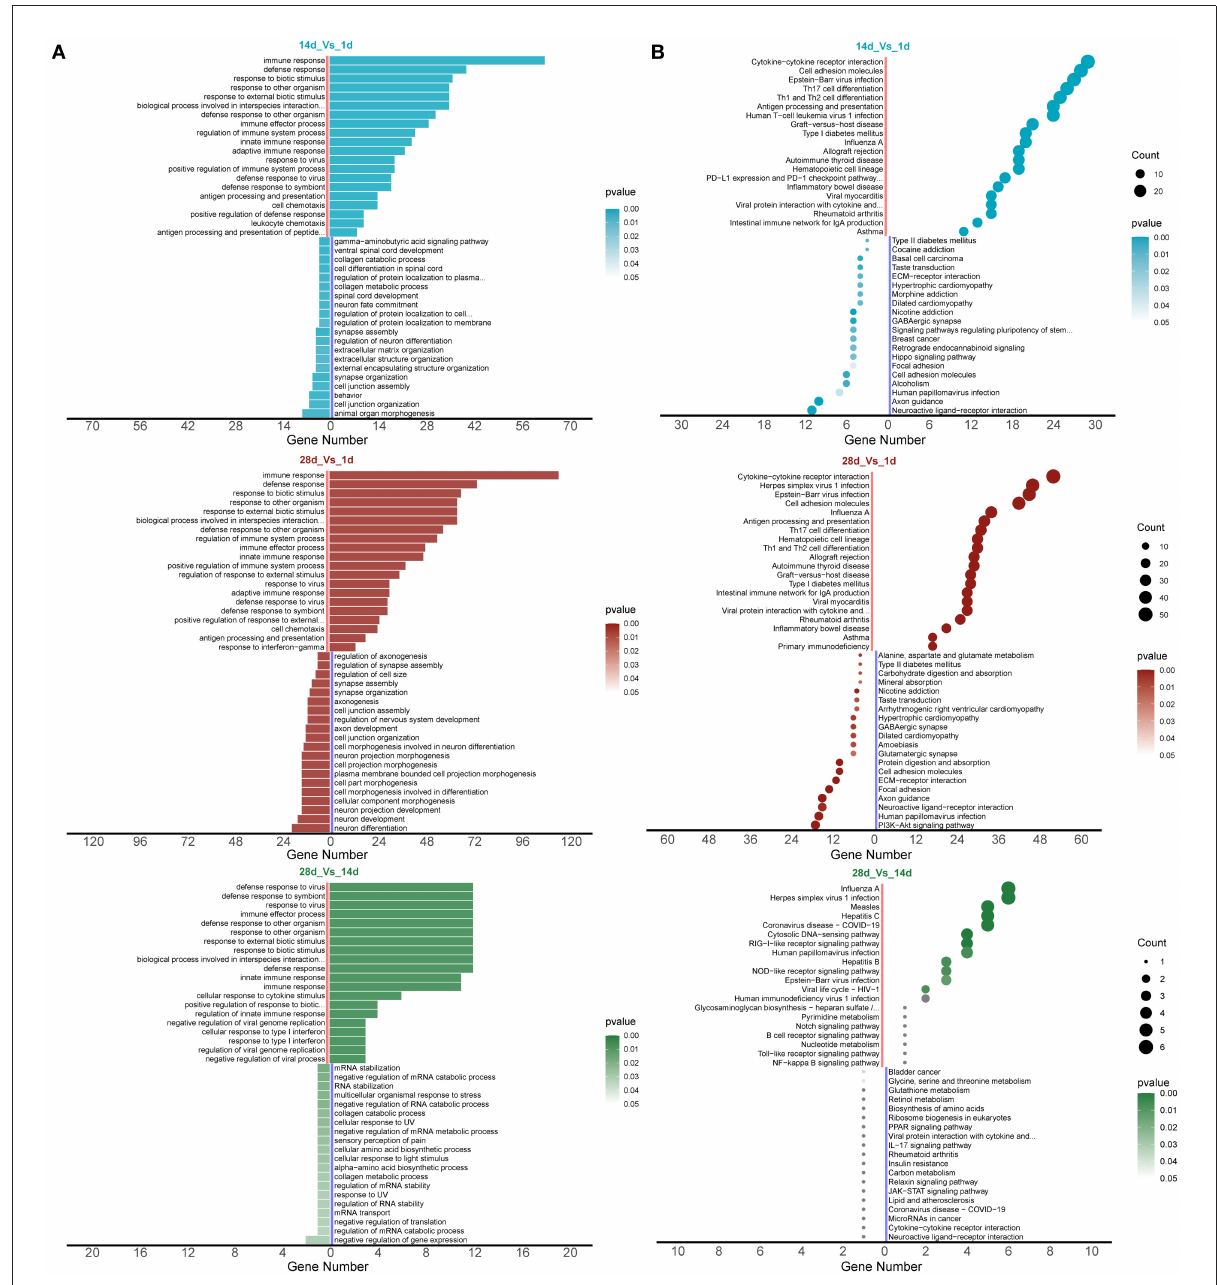
FIGURE4 mRNA enrichment analysis for differential expression. (A) GO enrichment analysis and (B) KEGG enrichment analysis.